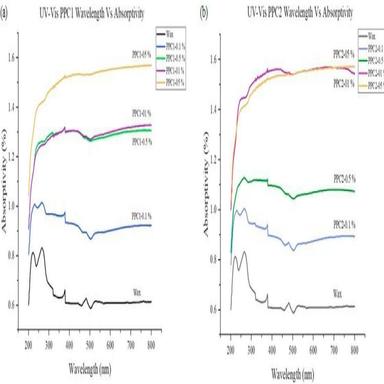
UVeVis results for a) PPC1 Wavelength vs Absorptivity; b) PPC2 Wavelength vs Absorptivity.